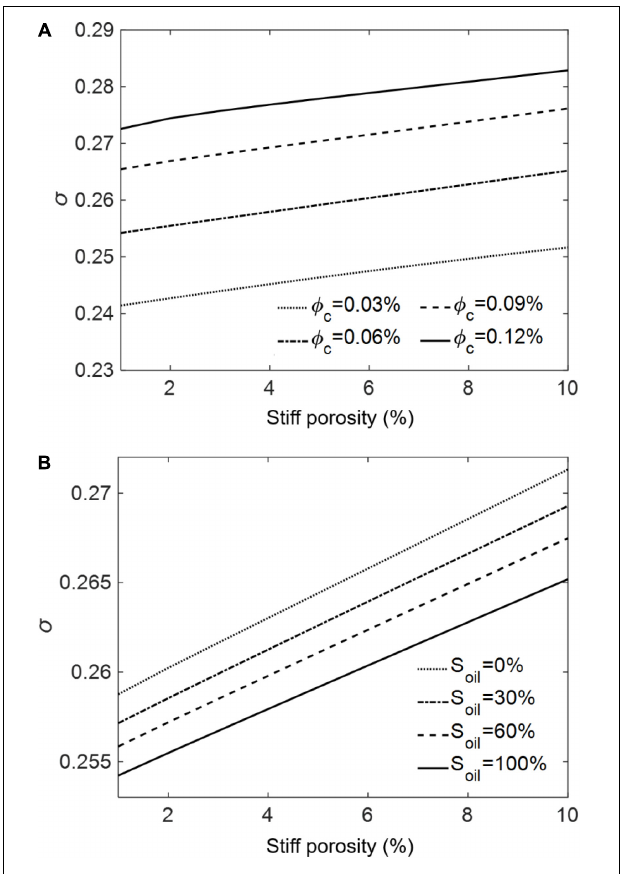
FIGURE 7 | Poisson’s ratio at 1 MHz as a function of stiff porosity for different crack (soft) porosities (A) and oil saturations (B) .